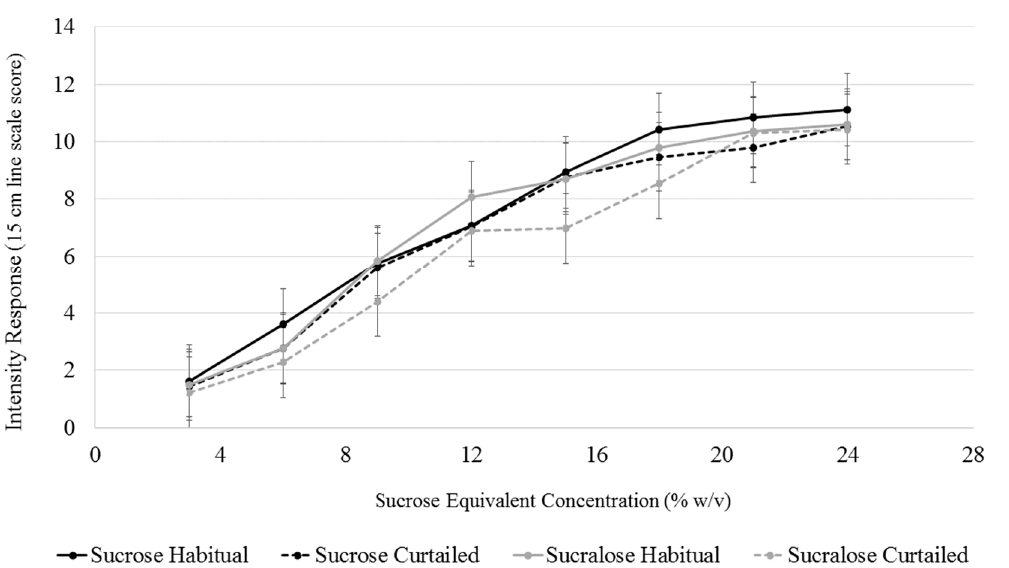
Figure 4. Comparison of intensity perception of sucrose and sucralose (in sucrose equivalents) after a habitual and curtailed night of sleep. No significant differences between the sweeteners after either sleep condition ( p > 0.05). Error bars represent standard error of the mean.